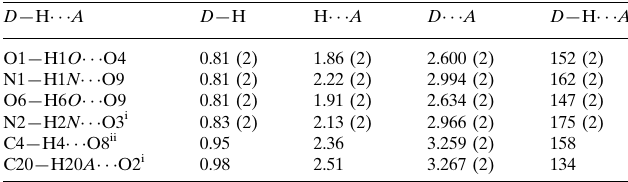
Hydrogen-bond geometry (A˚ , (cid:2)